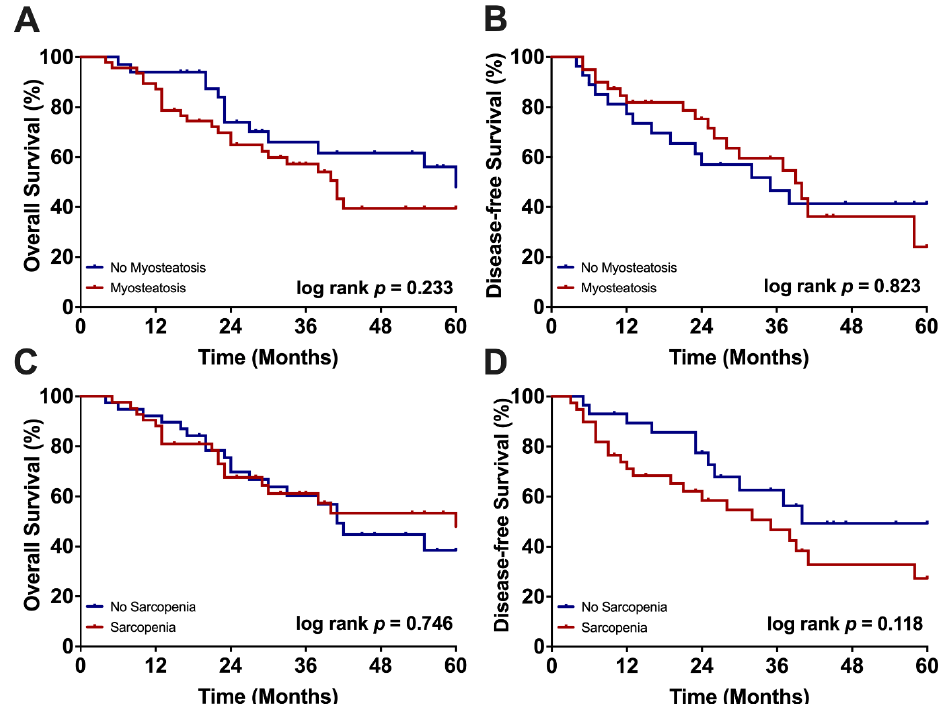
Figure 2. Overall and disease-free survival stratified by myosteatosis and sarcopenia. ( A ) Five-year survival of myosteatotic and non-myosteatotic patients. ( B ) Recurrence-free survival of myosteatotic and non-myosteatotic patients. ( C ) Five-year survival of sarcopenic and non-sarcopenic patients. ( D ) Recurrence-free survival of sarcopenic and non-sarcopenic patients.